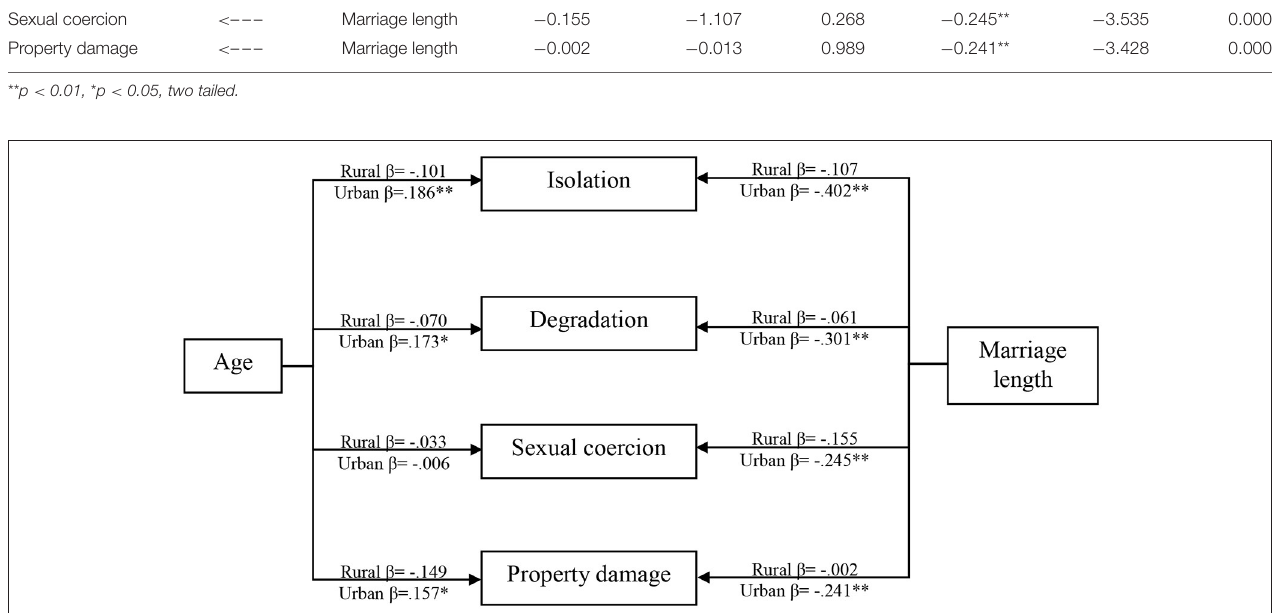
FIGURE 3 | Multi-group modeling between rural and urban